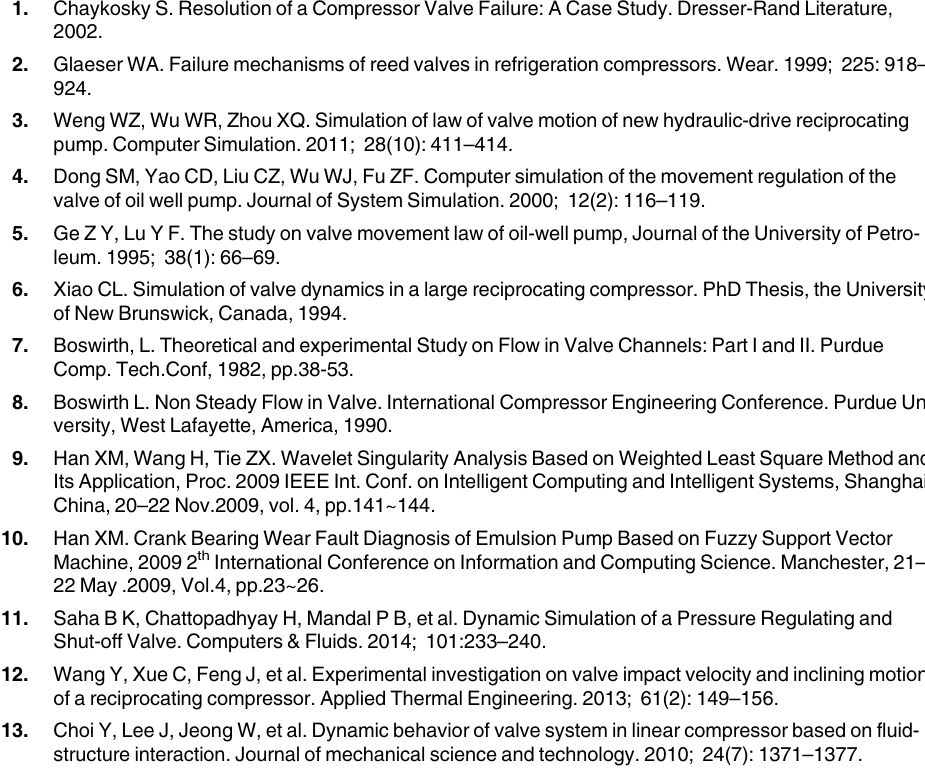
S5 Fig. The data acquisition process. (TIF) S6 Fig. The stress and strain nephogram of discharge valve components. (TIF) S1 Movie. The fluid field distribution during the simulation of fluid structure interaction. (MPG) S1 Table. Calibration zero of displacement sensors. (DOCX) S2 Table. The stress and strain values of pump valve components under different seating velocity for the optimized spring stiffness and valve body quality. (DOCX) S1 Text. The lift of discharge valve body in a stroke under different data collection points.